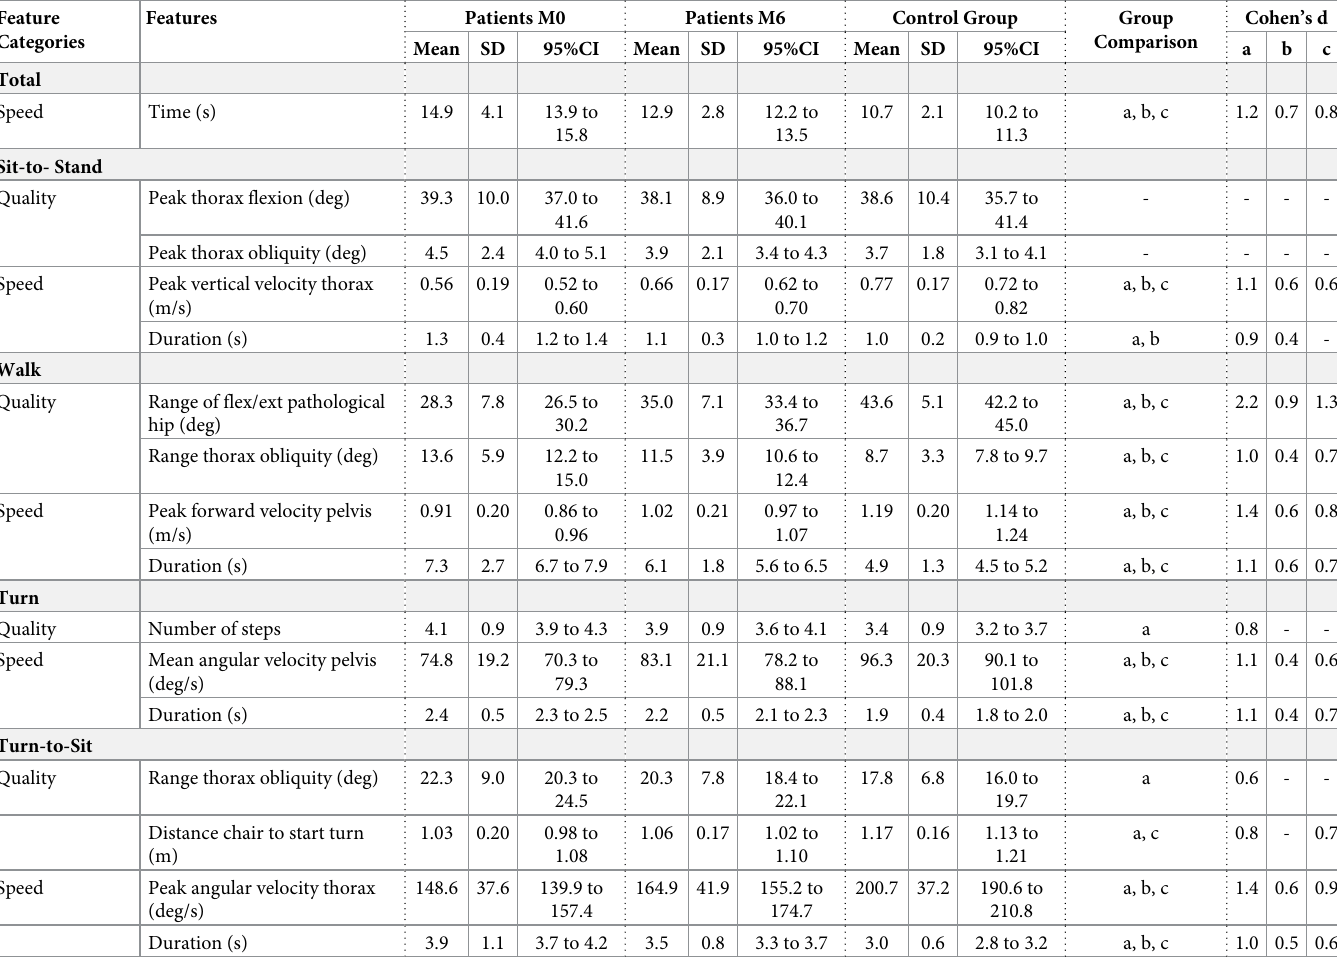
Table 4. Mean values (standard deviation) for patients before surgery (M0), patients six months after surgery (M6) and the control group. Feature Features Categories